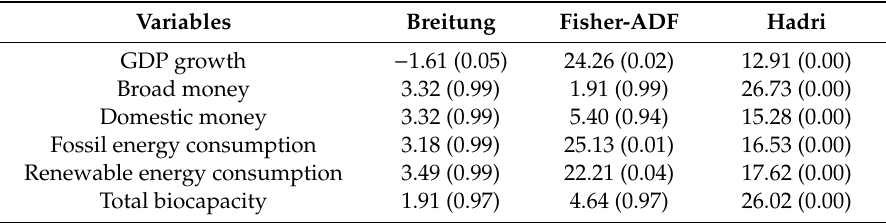
Table 4. Results of unit root